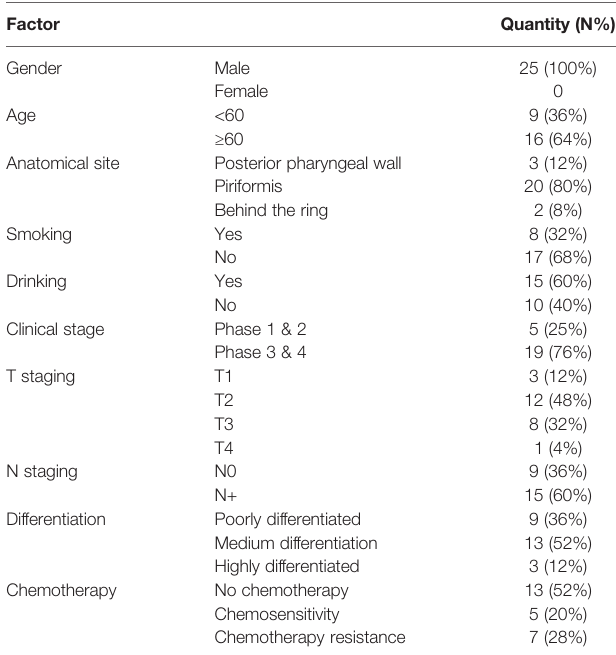
TABLE 1 | Clinical data of 25 patients with